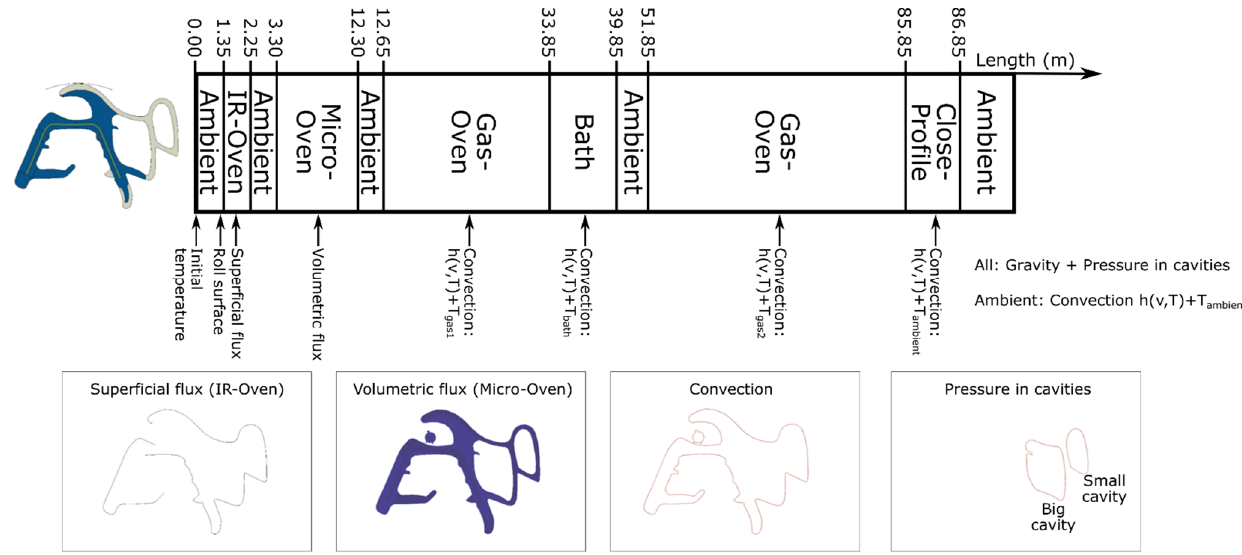
Figure 5. Scheme of the thermal treatment of the extrusion line and associated boundary conditions applied for the simulation.